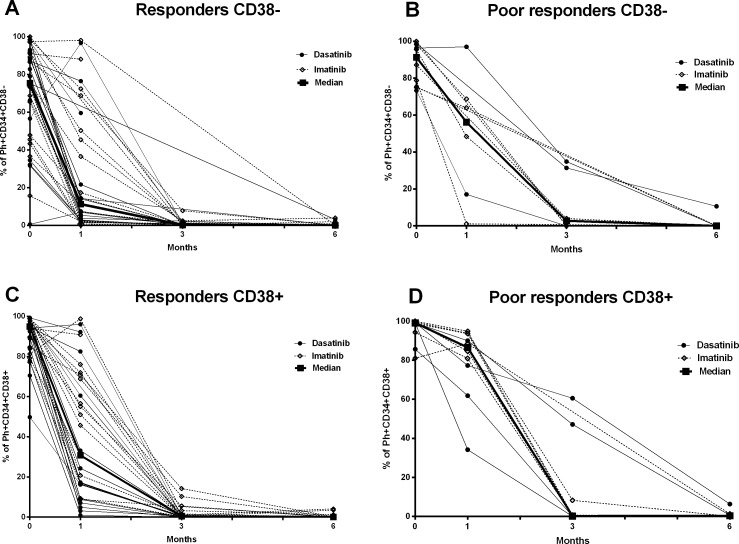
Ph+ in CD34+CD38- and CD34+CD38+ fractions decrease more slowly in the poor responders.The figure presents the proportions of Ph+ cells in CD34+CD38- (A and B) and CD34+CD38+ (C and D) fractions in responders (A and C) and poor responders (B and D) at the time of dg and during follow-up (1, 3, and 6 months). Imatinib-treated patients are presented with dashed lines and dasatinib-treated patients with solid lines. Medians in each group are marked with bold lines.